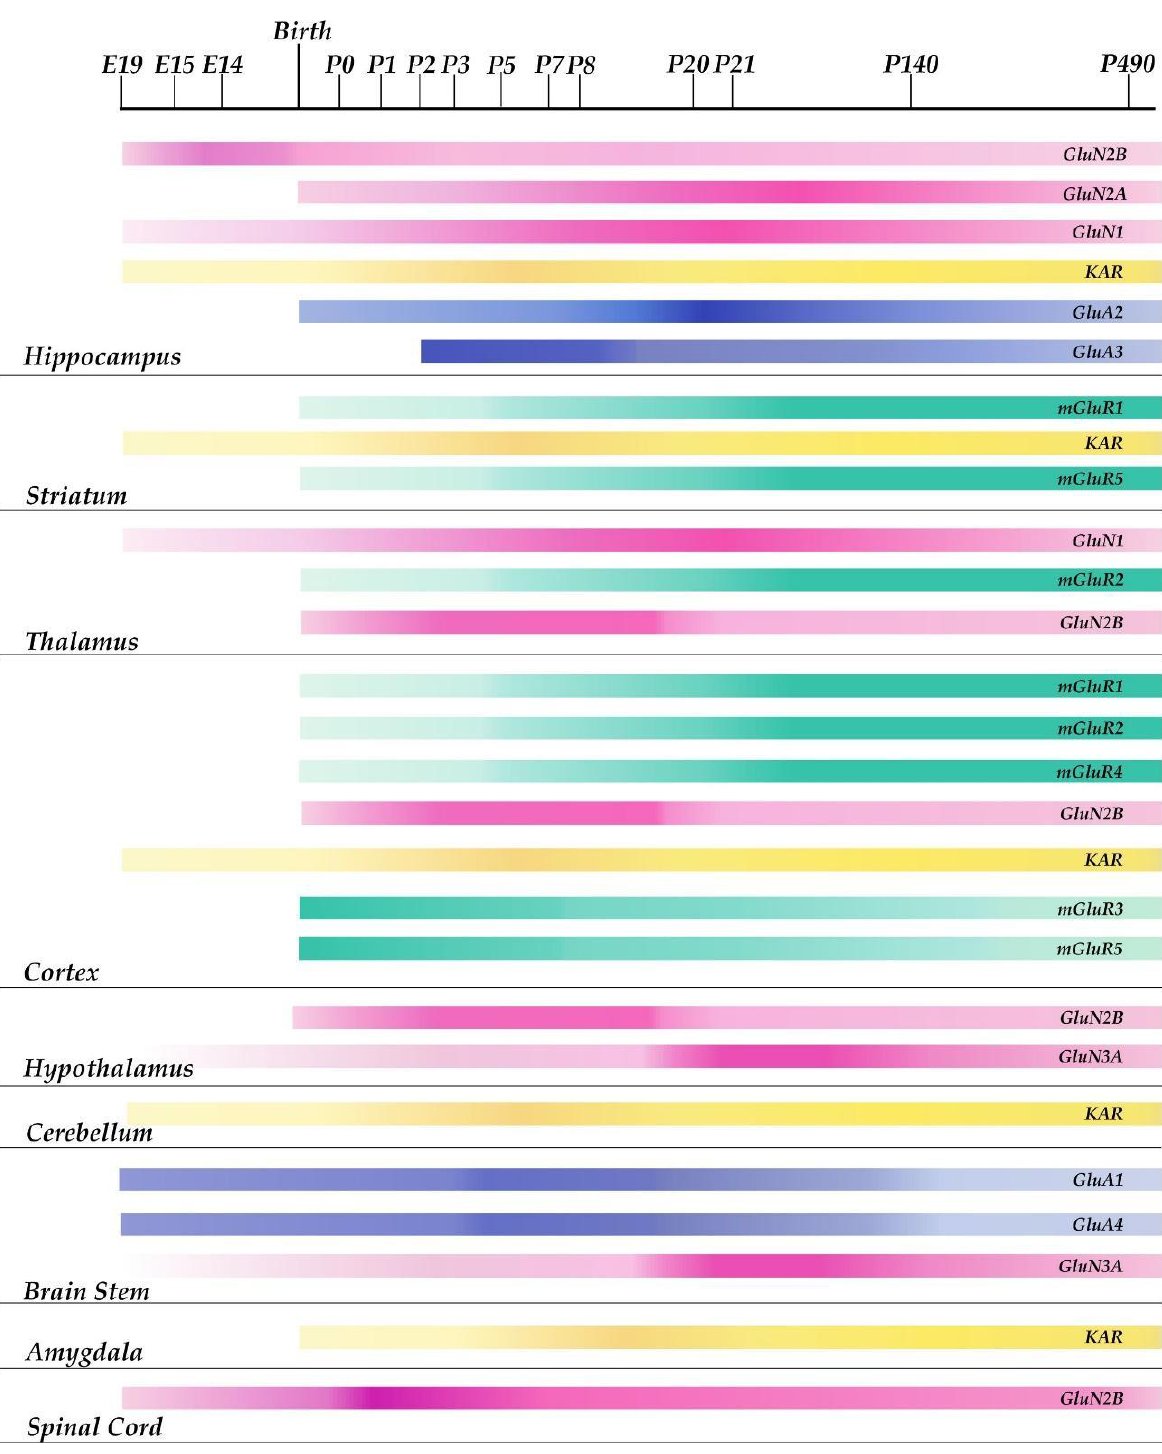
Figure 1. Schematic representation of the developmental time course of glutamatergic receptor subunits expression in different rodent brain areas. The variations in color intensity within the single bars represent changes along time in the expression levels of each receptor subunit in a particular area of the rodent brain. The midbrain, pons, and medulla are represented collectively as brain stem in the figure.